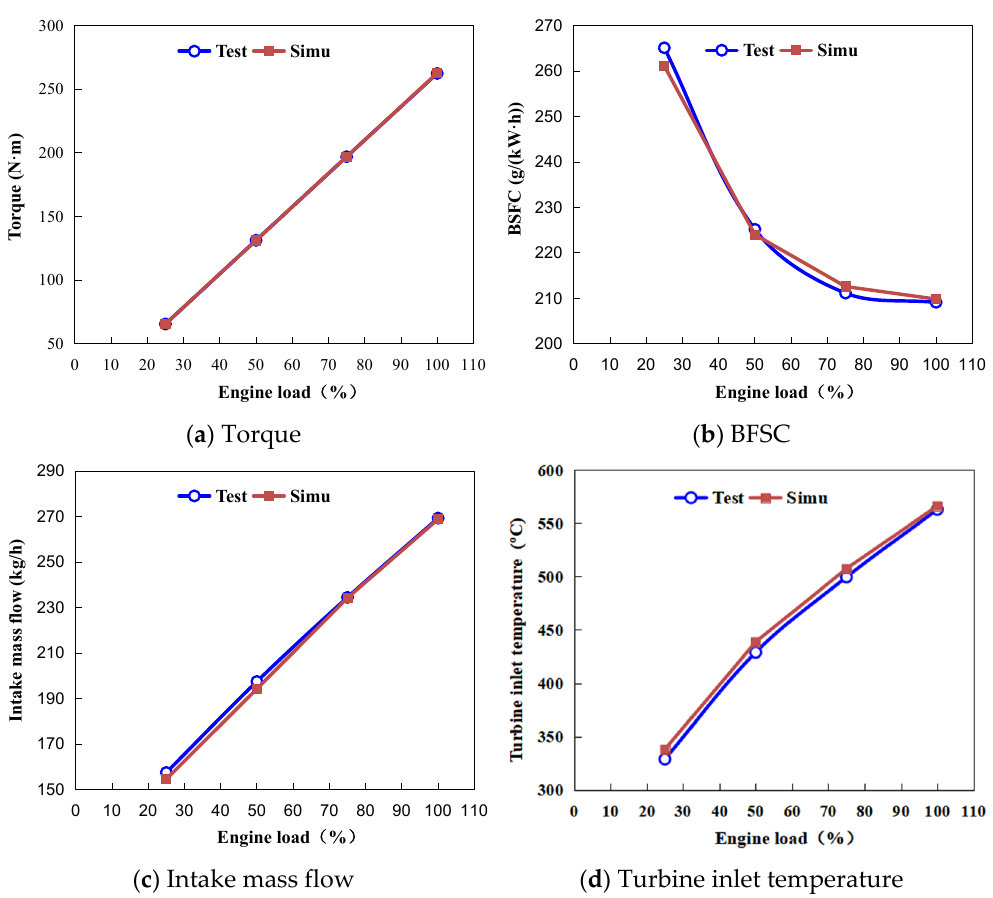
Figure 6. Comparison between the simulation results and test results at 2200 r/min, 100% load.